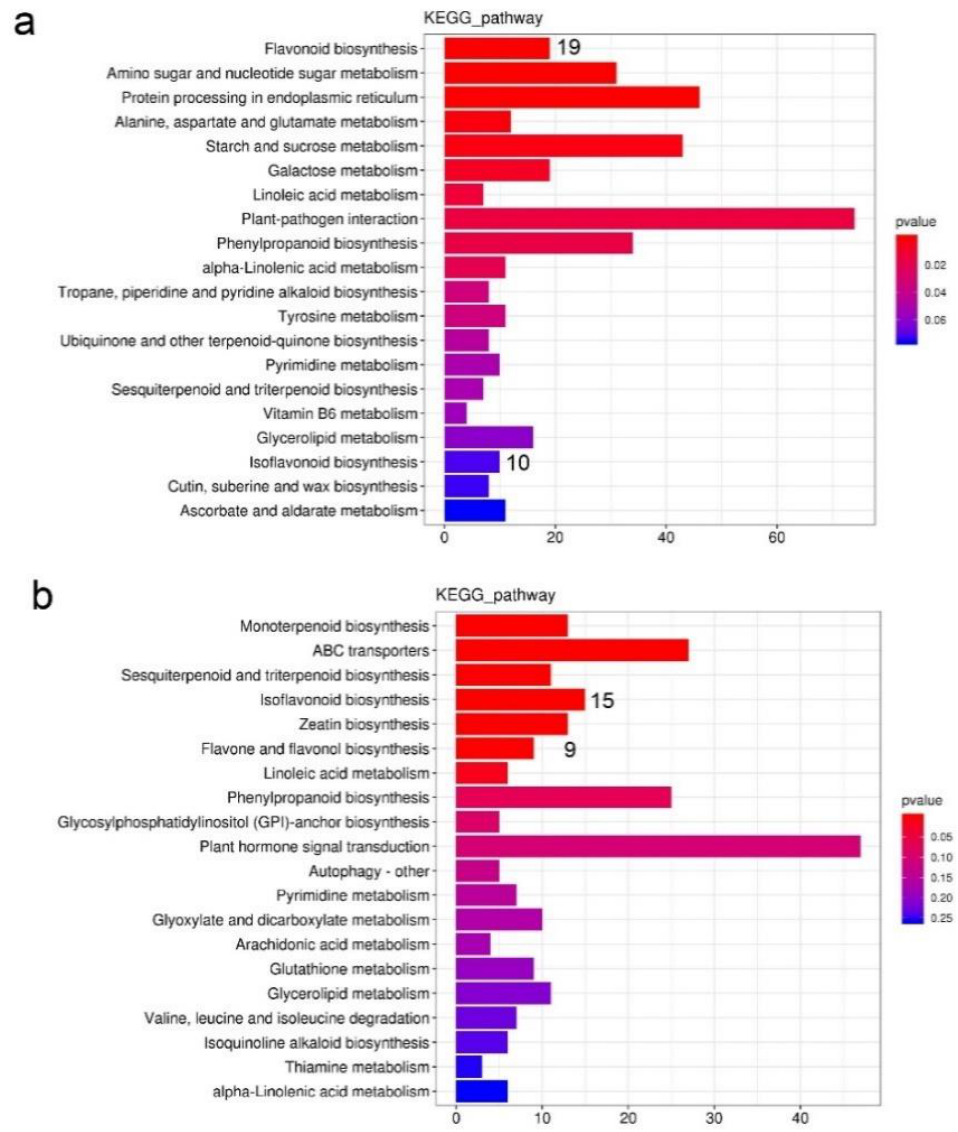
Figure 6. KEGG enrichment analysis of the differentially expressed genes (DEGs). In this study, PFMs served as the control group. ( a ) KEGG analysis of downregulated genes from the RNA-seq data. The Y -axis on the left represents the categories of the KEGG annotation, and the X -axis indicates